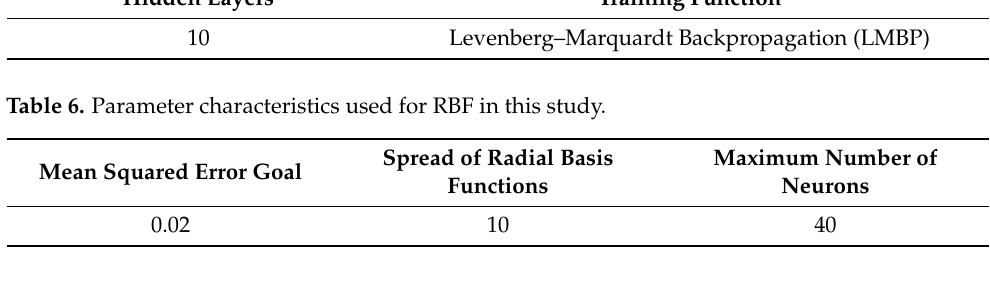
Table 7. Parameter characteristics used for FS in this